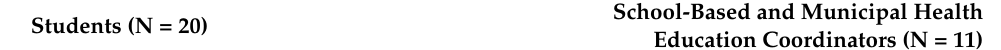
Table 1. Socio-demographic characteristics of interview respondents in Lower Manya Krobo Munici- pality, Ghana (N =